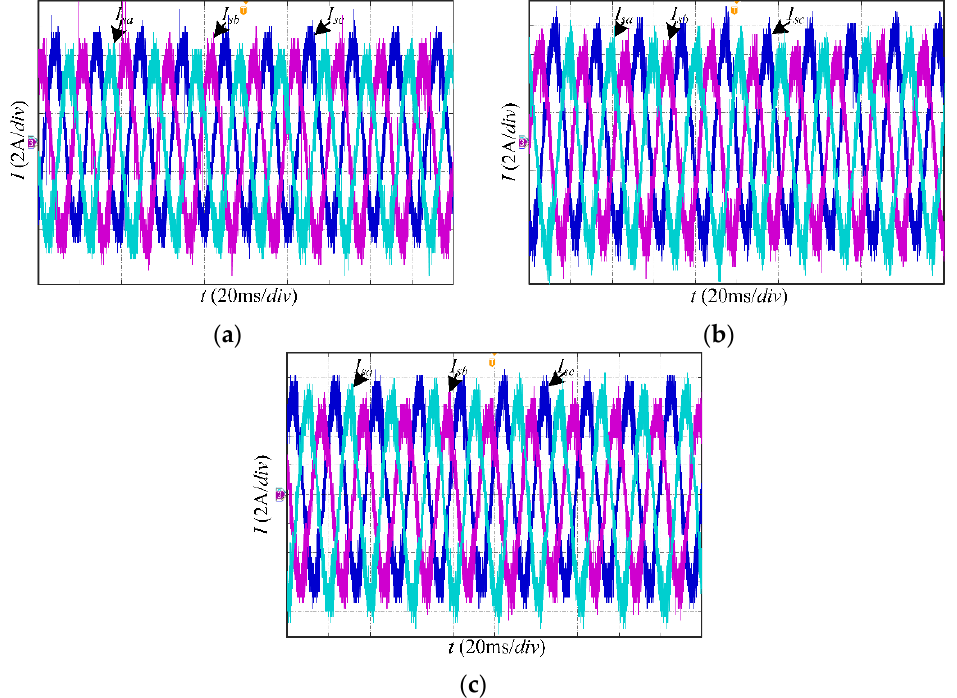
Figure 13. Stator three-phase currents at 30% T N : ( a ) healthy condition. ( b ) B, C phase in series with 1 Ω resistors. ( c ) B, C phase in series with 2 Ω